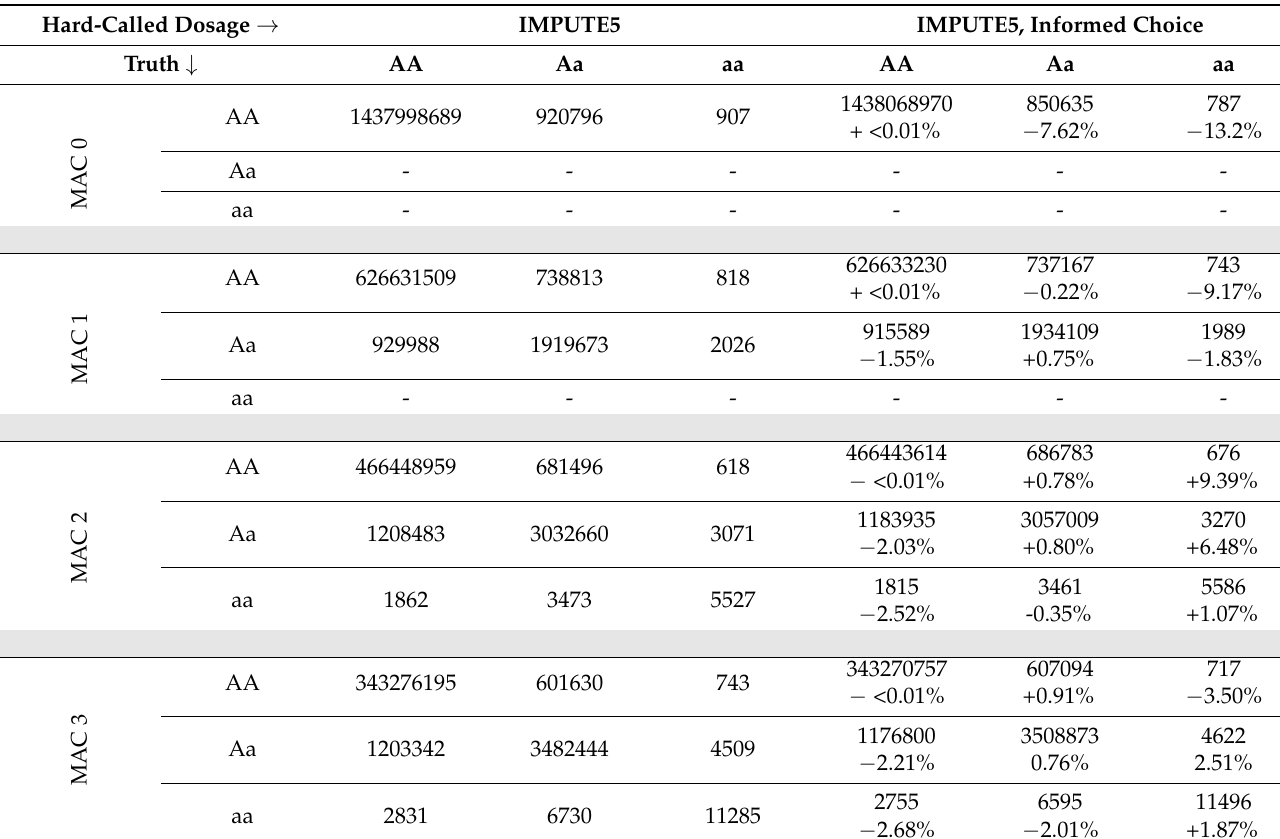
Table 1. Details of the imputation of genotypes for variants which were truly monomorphic in the complete target group, or had a minor allele count (MAC) of one, two, or three in the complete target group (ACB, ASW, and MXL combined). The table compares true genotypes with hard-called imputed genotypes when either imputing with IMPUTE5 and the whole of the 1000G (minus the three target populations) as a reference panel, or with the same software and reference panel but when each target haplotype was imputed with a chosen subset of reference haplotypes informed by the imputation barcodes (‘informed choice’). For the ‘informed choice’ columns, each cell also includes the percentage increase or decrease compared to the corresponding cells when using all populations. AA refers to homozygous-for-the-reference genotypes, Aa for heterozygous genotypes, and aa for homozygous-for-the-alternative genotypes. Here, MAC is measured across the whole target group: ASW, ACB, and MXL